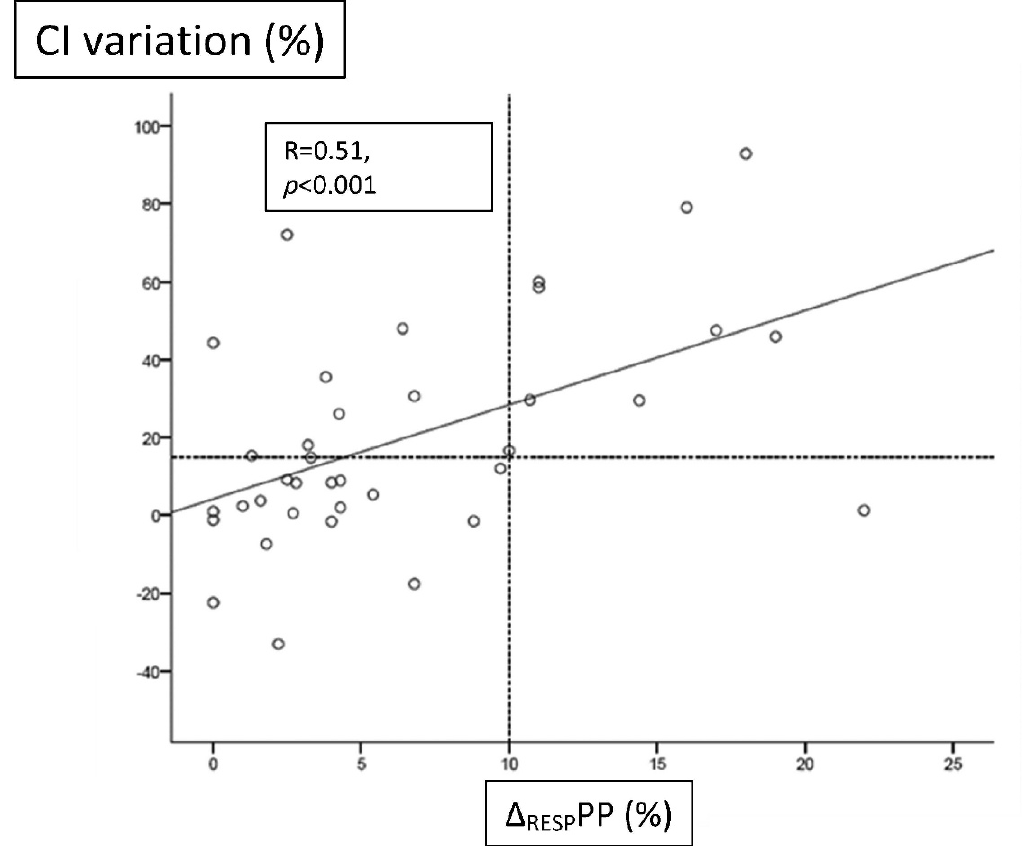
Figure 2 - Linear correlation between the pulse pressure variation ( D RESP PP) and cardiac index (CI) variation immediately after a